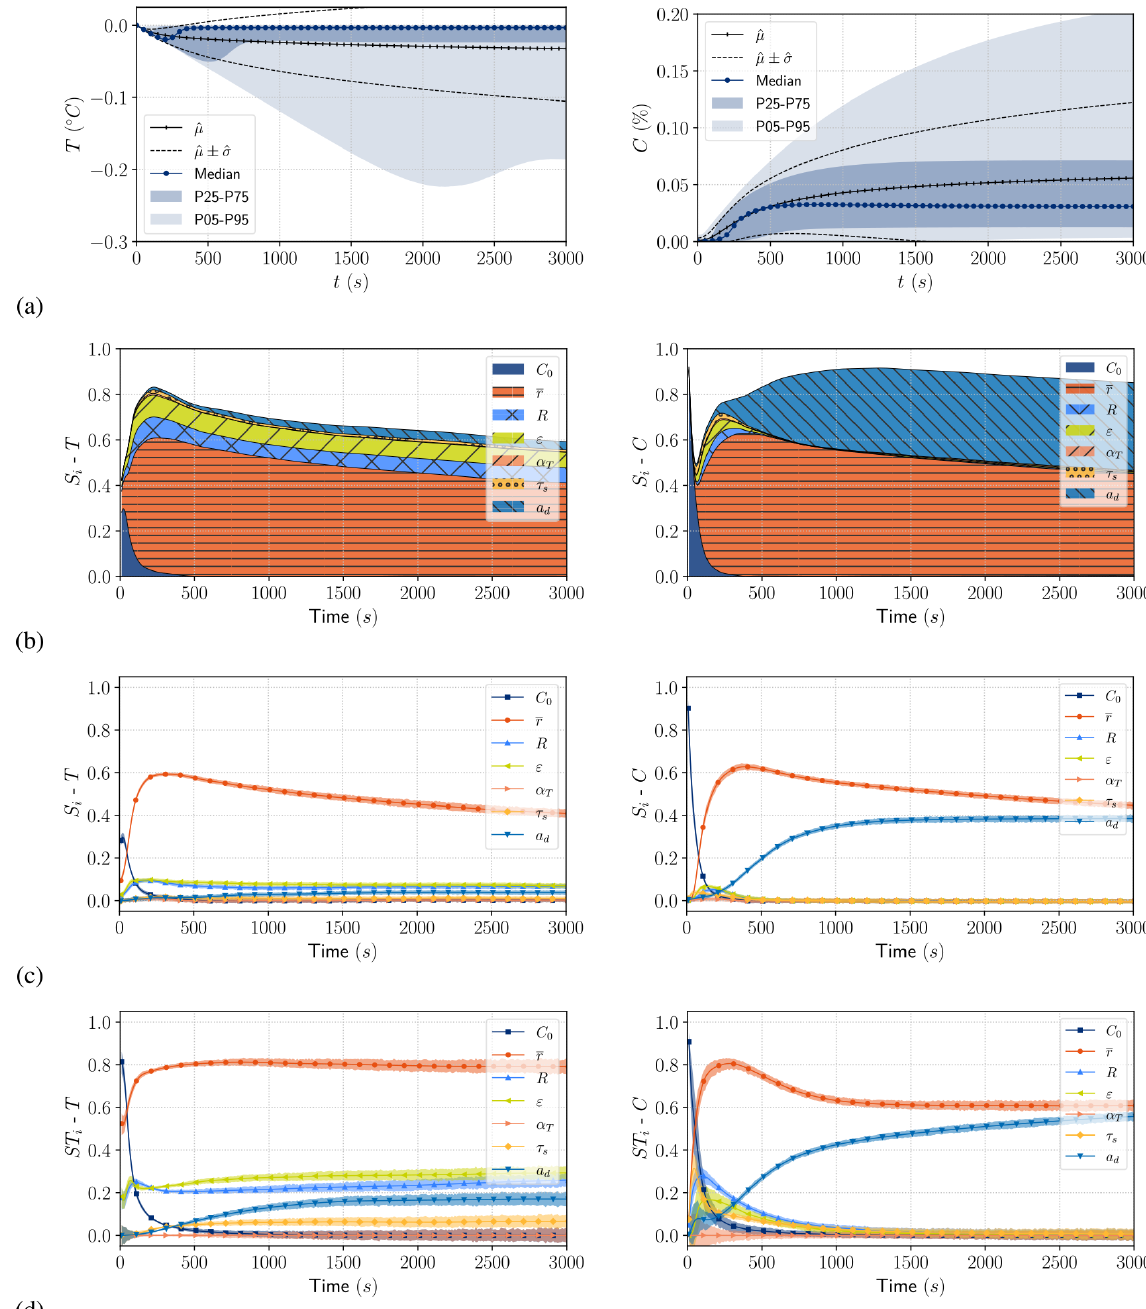
Figure H1. Results of case 3. From top to bottom: uncertainty propagation result (a) , first-order Sobol indices (b) , first-order Sobol indices with 95% confidence intervals (c) , and total-order Sobol indices with 95% confidence intervals (d) for temperature (left panels) and frazil (right